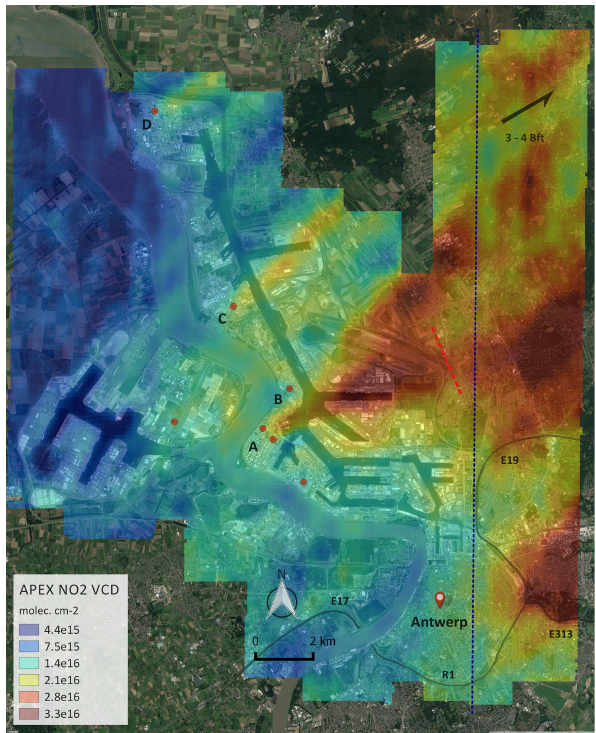
Figure 15. Retrieved NO 2 VCD field for Antwerp (15 April 2015) (Google, TerraMetrics). Red dots indicate the chimney stacks, emit- ting more than 25kg of NO x per hour, according to the emission inventory of the Belgian Interregional Environment Agency. Four industrial sites, which are further discussed in Sect. 5, are indicated by the labels A–D. The red dotted line indicates the plume cross section, plotted in Fig. 5. The blue vertical line indicates an along- track profile, for which the NO 2 DSCD and VCD time series are plotted in Fig. 16.